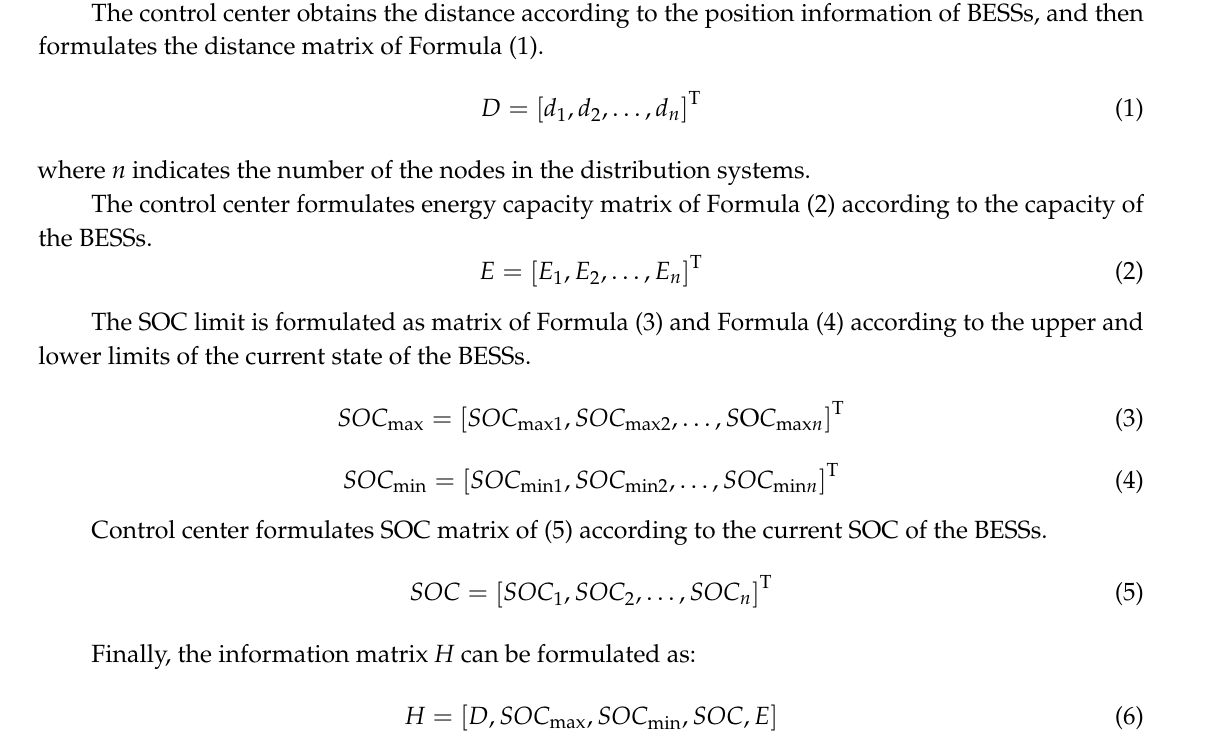
Figure 2. Battery energy storage systems (BESS) model.